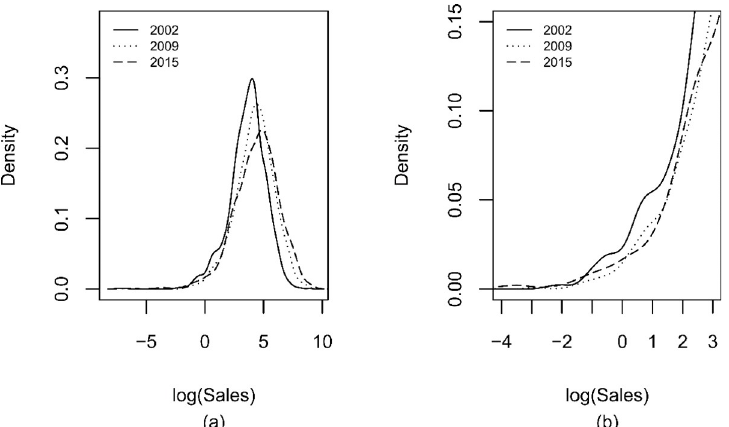
Fig 1. Empirical density of the logarithm of sales. The figure shows the density of the logarithm of the sales variable (log (Sales)) resulting from a smoothing of the corresponding histogram. The panel (a) represents the total of the domain and (b) a detail of the left tails, where the smallest firms in terms of sales are located. Sales were divided by the factor 10 8